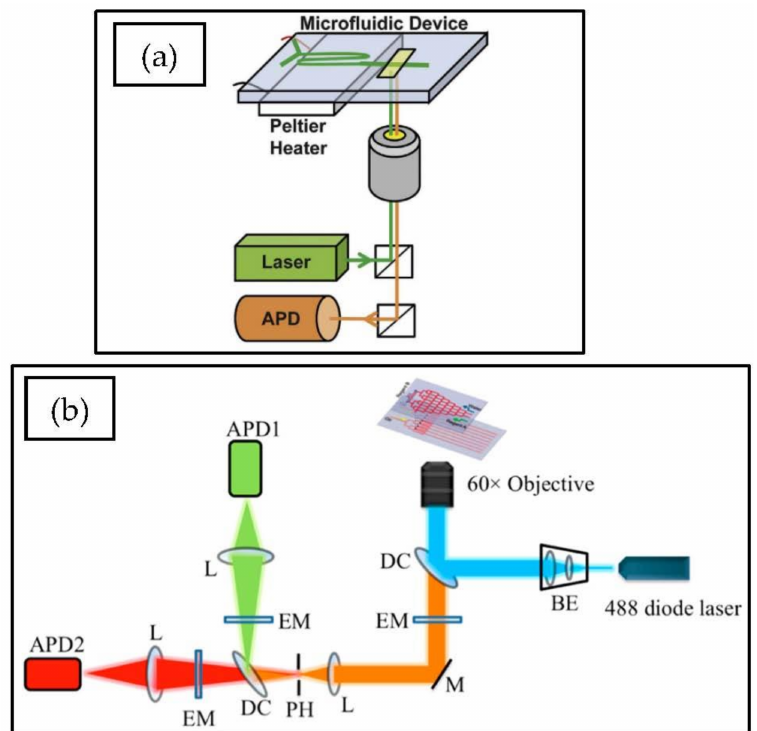
Figure 8. Detection setups used in droplet microflow cytometry (DMFC) using photodiodes or avalanche photodiodes (APD) as a detector. ( a ) Microfluidic measurement system where a laser is used for excitation and APD is used as a detector. Additionally, optics are used to focus light on the sample. ( b ) Microfluidic measurement system where Differential Detection Photothermal Interferometry is used and two photodiodes collect the data that is collected with a lock-in amplifier and analyzed in PC. Reproduced from with permission from